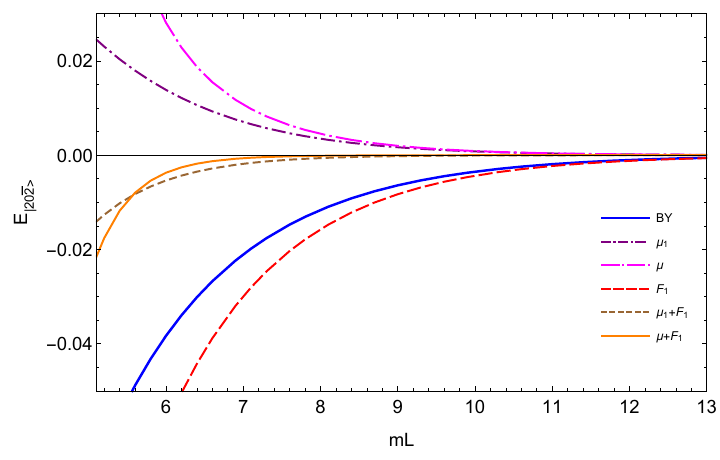
Figure 10 . Exponential (cid:12)nite size energy correction for the state labeled by the quantum numbers f 2 ; 0 ; (cid:0) 2 g . \ F " is the F-term correction, while \ (cid:22) " is the leading (cid:22) -term correction. \ (cid:22) " contains 1 1 all the (cid:22) -term corrections summed up, while \ (cid:22) + F " adds the F -term correction to this. 1 has to be subtracted. The (cid:12)nite size spectrum obtained by the TCSA method after the subtraction looks like in (cid:12)gure